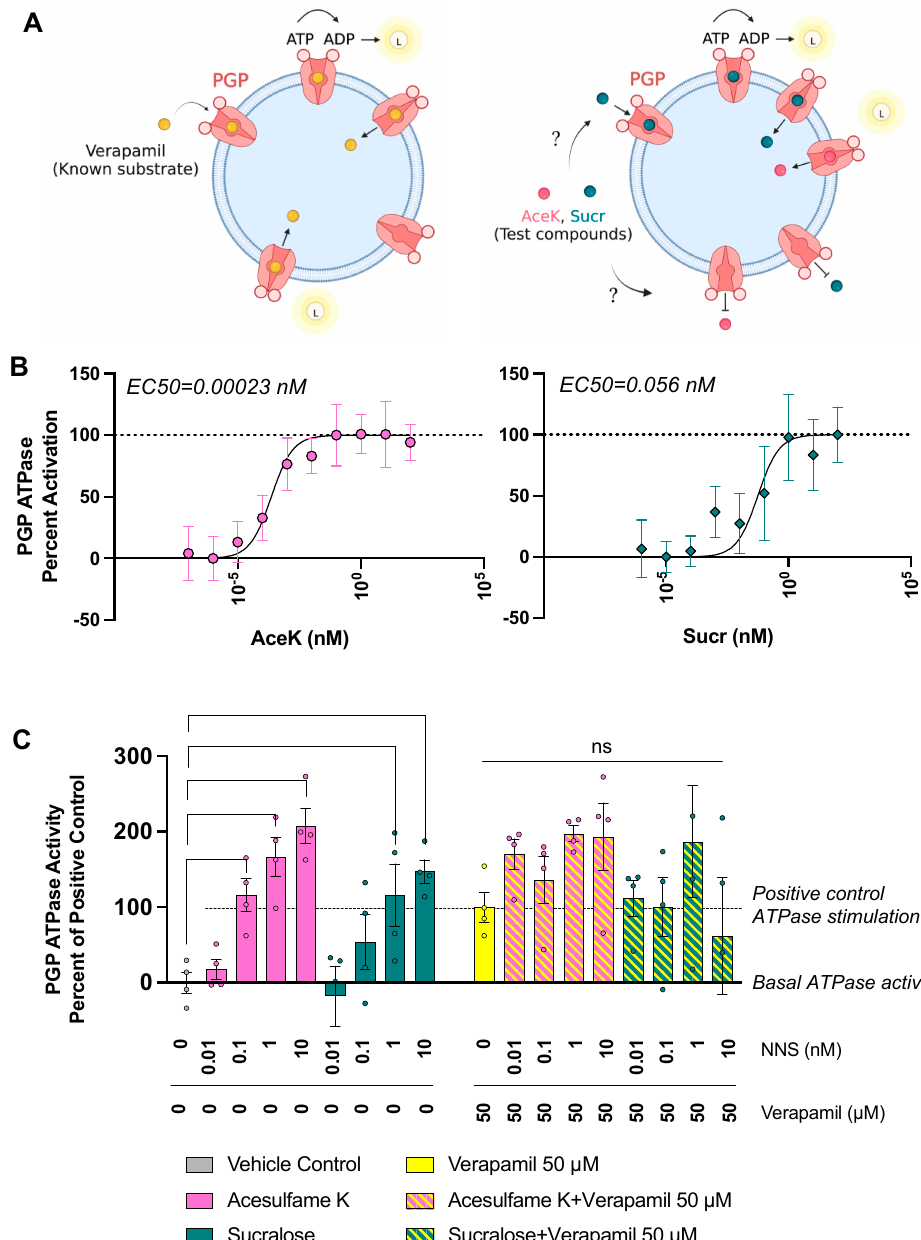
Figure 3. AceK and Sucr stimulate PGP ATPase activity. (A) ATP hydrolysis is required for the conformational change that accomplishes substrate efflux. PGP ATPase activity can be assessed in a cell-free assay. Vesicles containing human PGP are treated with compounds known to stimulate ATP hydrolysis and test compounds. Created with BioRender ( B ) PGP membranes were treated with increasing concentrations of AceK or Sucr. Ec50 values were determined by non-linear fitting of [Agonist] vs. response (95% CI: AceK, 6.074 × 10 − 5 to 0.001089 nM; Sucr, 004922 to 0.4787 nM). ( C ) AceK and Sucr were incubated with PGP membranes individually and in the presence of 50 µ M Verapamil. Verapamil, a known substrate of PGP, leads to strong stimulation of ATPase activity alone. AceK and Sucr individually stimulate PGP ATPase activity in a dose-dependent manner. Co-incubation of AceK or Sucr with Verapamil does not significantly increase or decrease ATPase stimulation relative to Verapamil alone. Significance was assessed by ordinary one-way